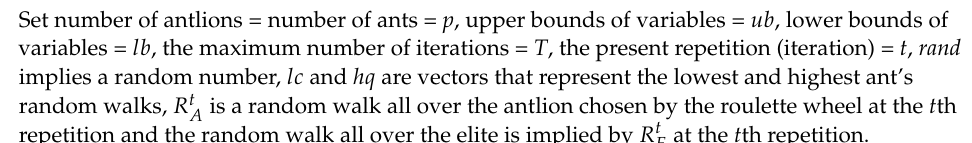
Algorithm 1: Pseudocode of